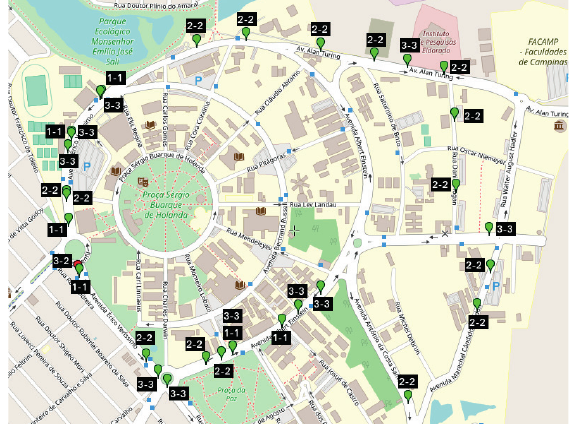
Figure 8. Map created with Random Forest.